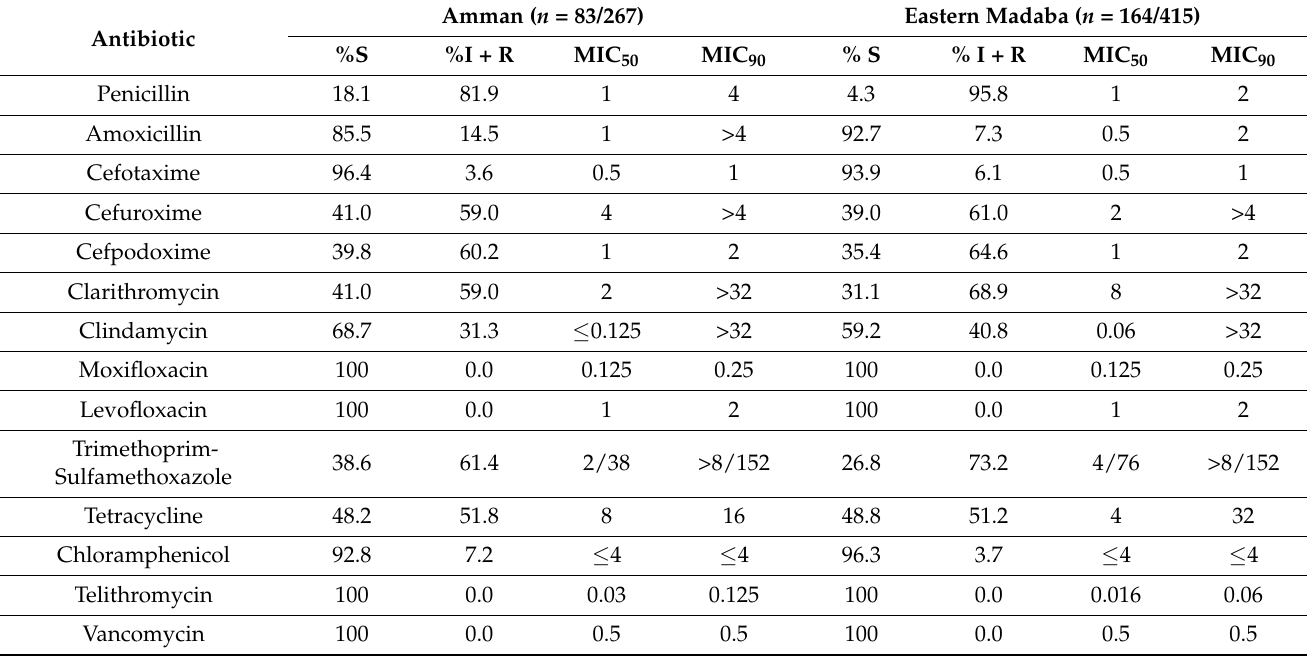
Table 3. Comparison of antibiotic resistance in both Amman and eastern